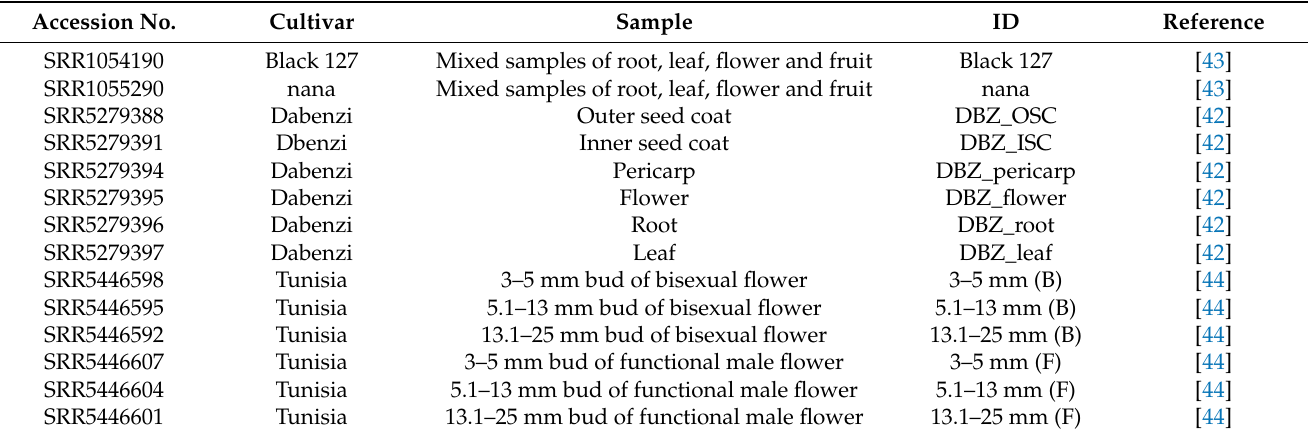
Table 3. RNA-seq data of